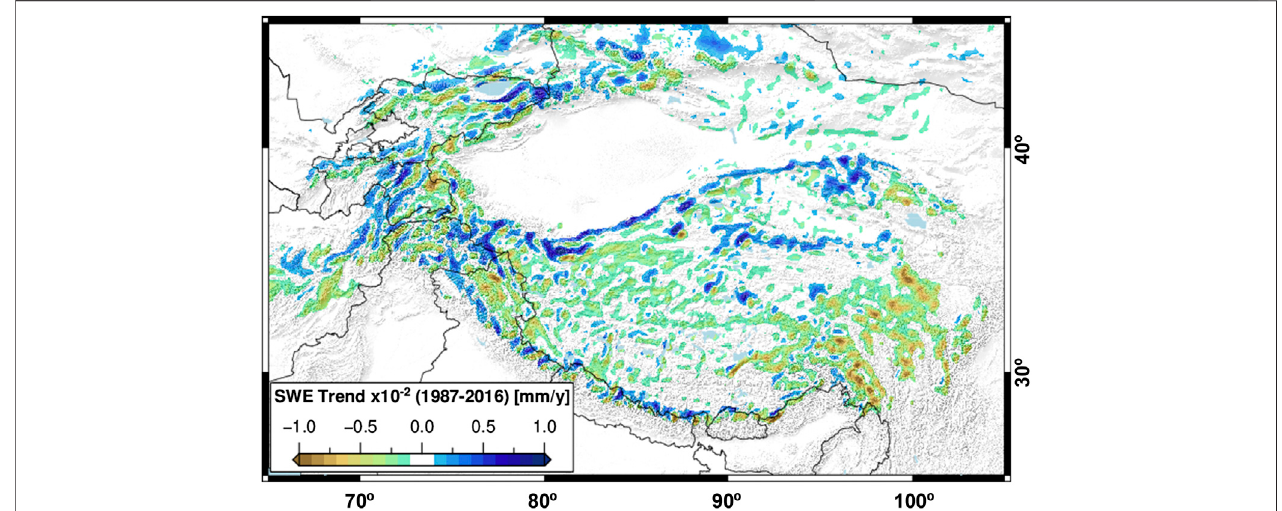
FIGURE 3 | Annual snow-water equivalent (SWE) trends (1987 – 2016) for High Mountain Asia (HMA). There is no spatially coherent SWE trend throughout HMA, but rather several 100 km 2 × 100 km 2 or larger regions with similar characteristics (Fujita and Nuimura, 2011; Smith and Bookhagen, 2018; Wang et al., 2018). Large- scale negative SWE trends are observed in the Tien Shan and Pamir Mountains in western HMA, and at the eastern margin of the Tibetan plateau. The Kunlun Shan, Karakoram, and western Himalaya are characterized by positive SWEs trends.